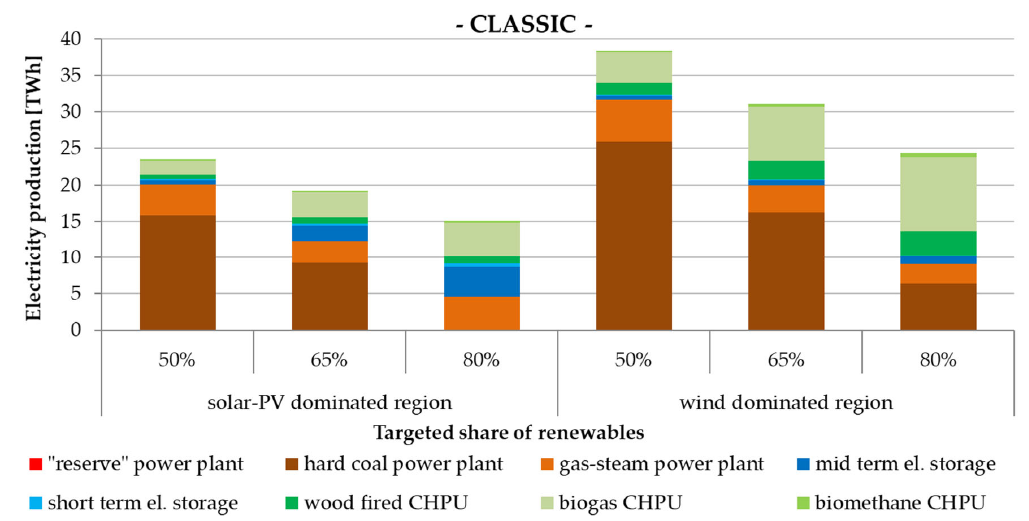
Figure 2. Covering of remaining residual load by the different plants or EESS of the fleet.